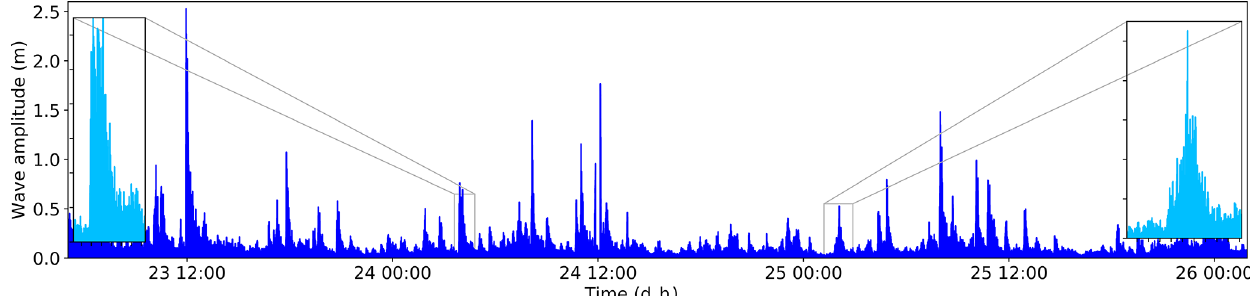
Figure 9. Calving waves detected with a pressure sensor. The light blue inset panels show details of the two wave types due to calving events. The left one has a sharp onset, while the right one shows gradual increase and decrease in wave amplitude.